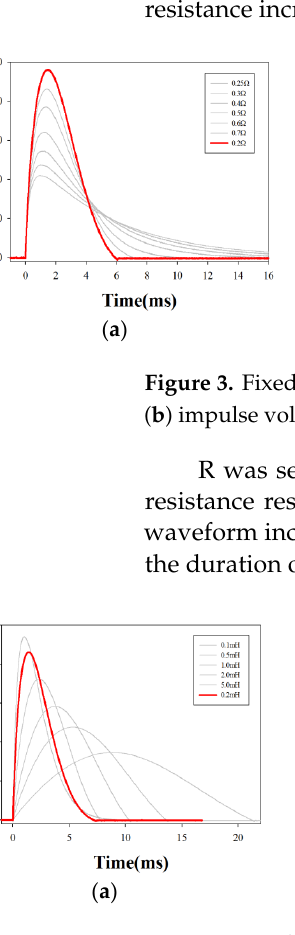
Figure 4. Fixed impulse test platform with R = 0.2 m Ω while varying L: ( a ) impulse current waveform; ( b ) impulse voltage waveform; ( c ) resistance response waveform.